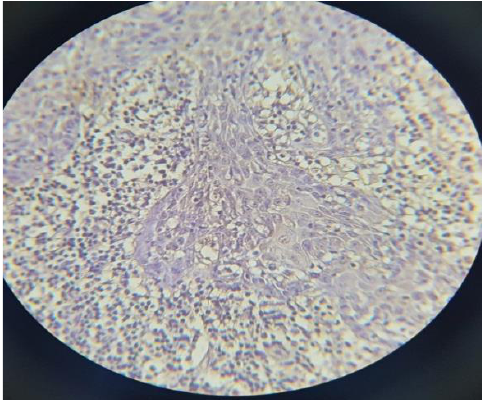
Figure 1: No staining (Score0 in SIS ) of Ang-2 expression of the studied samples. (X100).